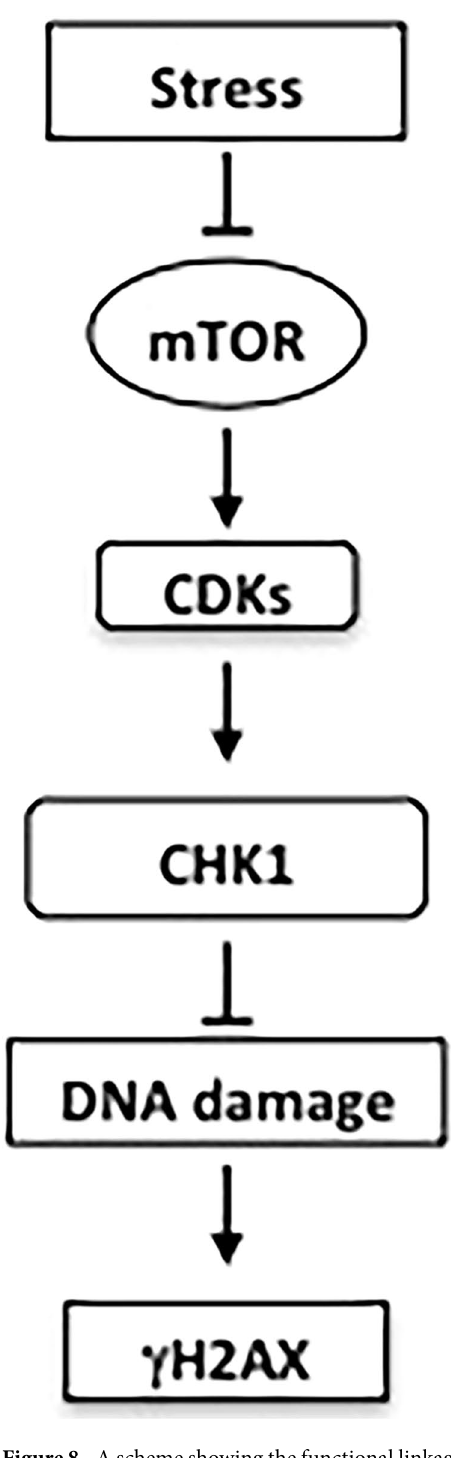
Figure 8. A scheme showing the functional linkage among the mTOR pathway, metabolic stress and DNA damage response by